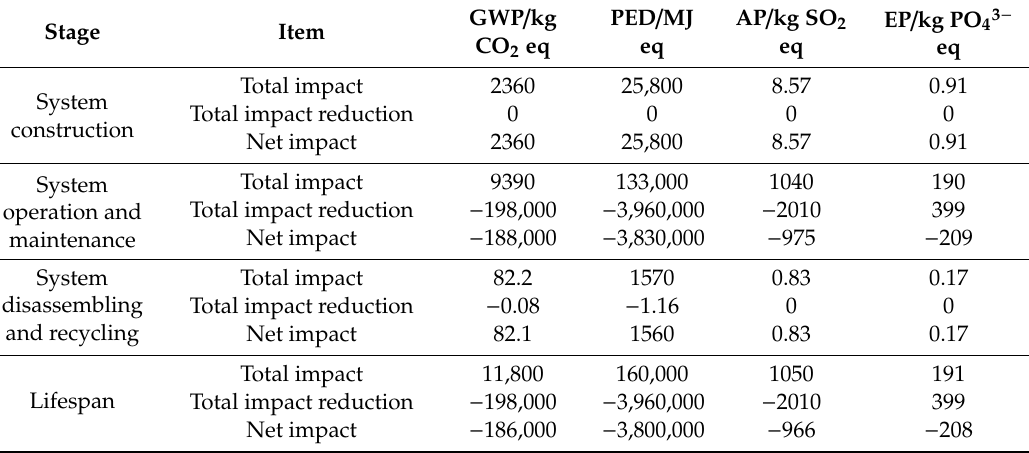
Table 3. Life-cycle impact results of the overall